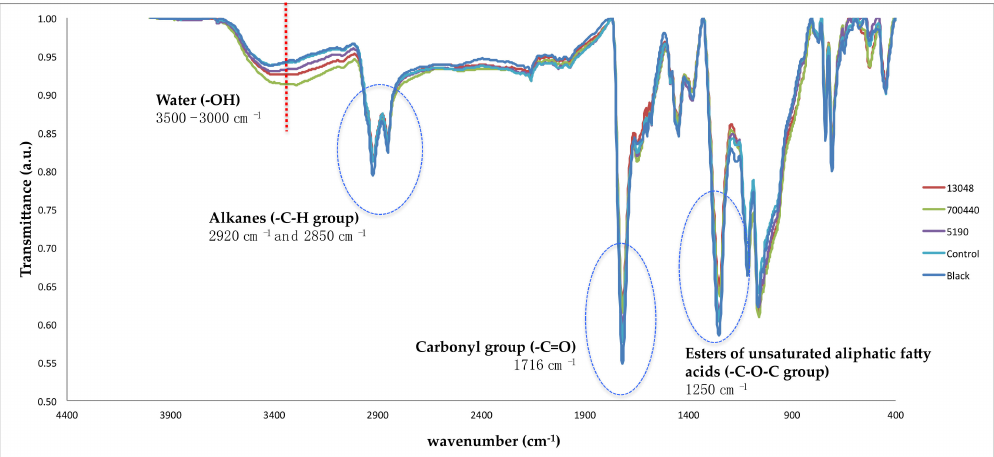
Figure 7. Infrared spectra of silver powdered graffiti after treatment with bacteria. Silver graffiti spray paint; control, without bacteria; 13,048 corresponds to Aerobacter aerogenes ; 700,440 corresponds to Comamonas sp., and 5190 corresponds to Pseudomonas stutzeri .